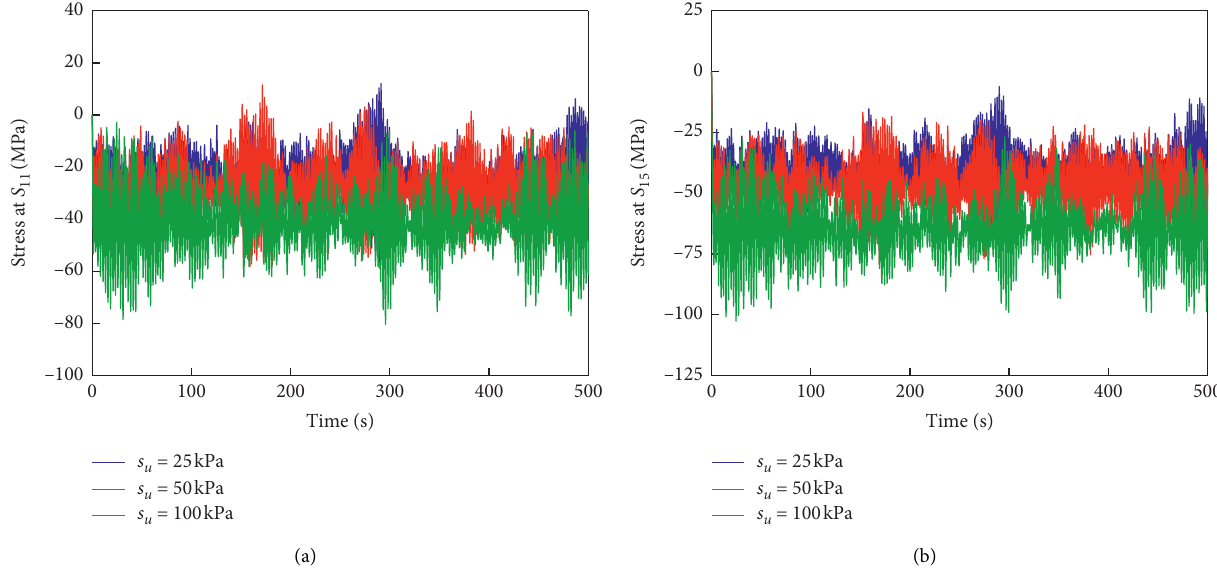
Figure 13: Comparison of stress on seabed cross section for different soil conditions: (a) time histories of stress at S stress at S 15 ( v � 36cm/s, h � 8cm, σ � 1.0